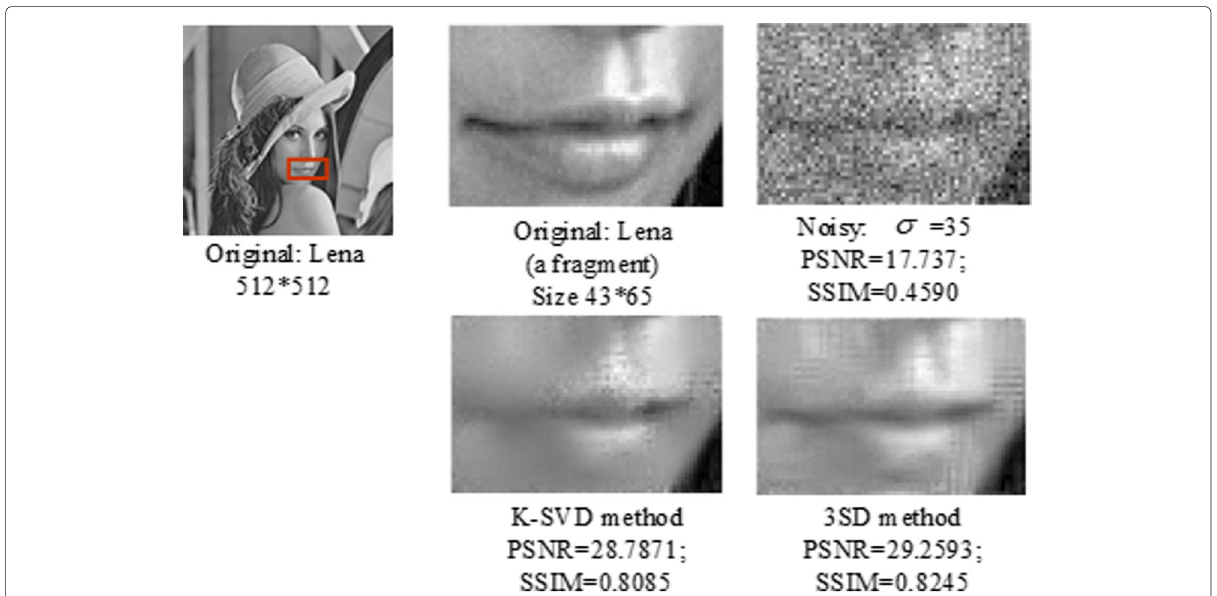
Fig. 5 Image denoising comparing the proposed 3SD method with the K-SVD method